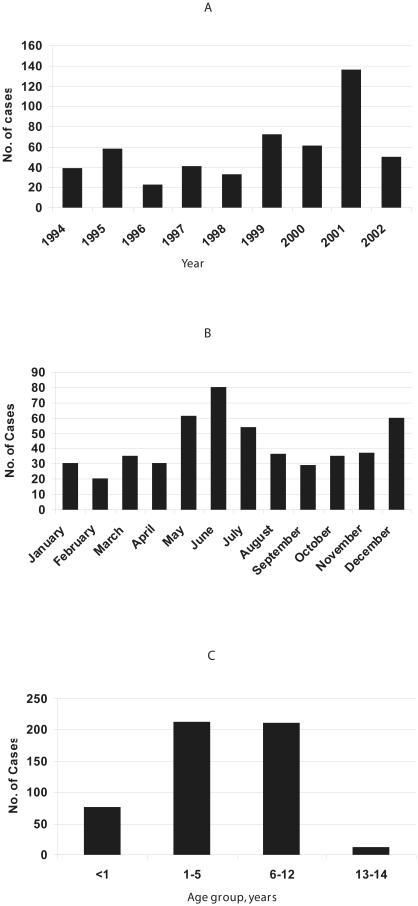
Distribution of Aseptic Meningitis Cases by Year (panel A), Month (panel B), and Age Group (panel C).